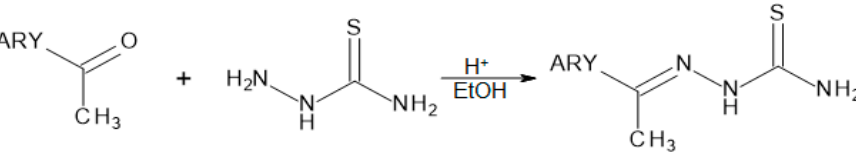
Scheme 1. Reaction scheme according to 1 H-NMR spectroscopy and compared with literature data; in the case of the new TSCs, 13 C-NMR and HRMS were also performed (Figures S1–S40, Sup- plementary Materials).